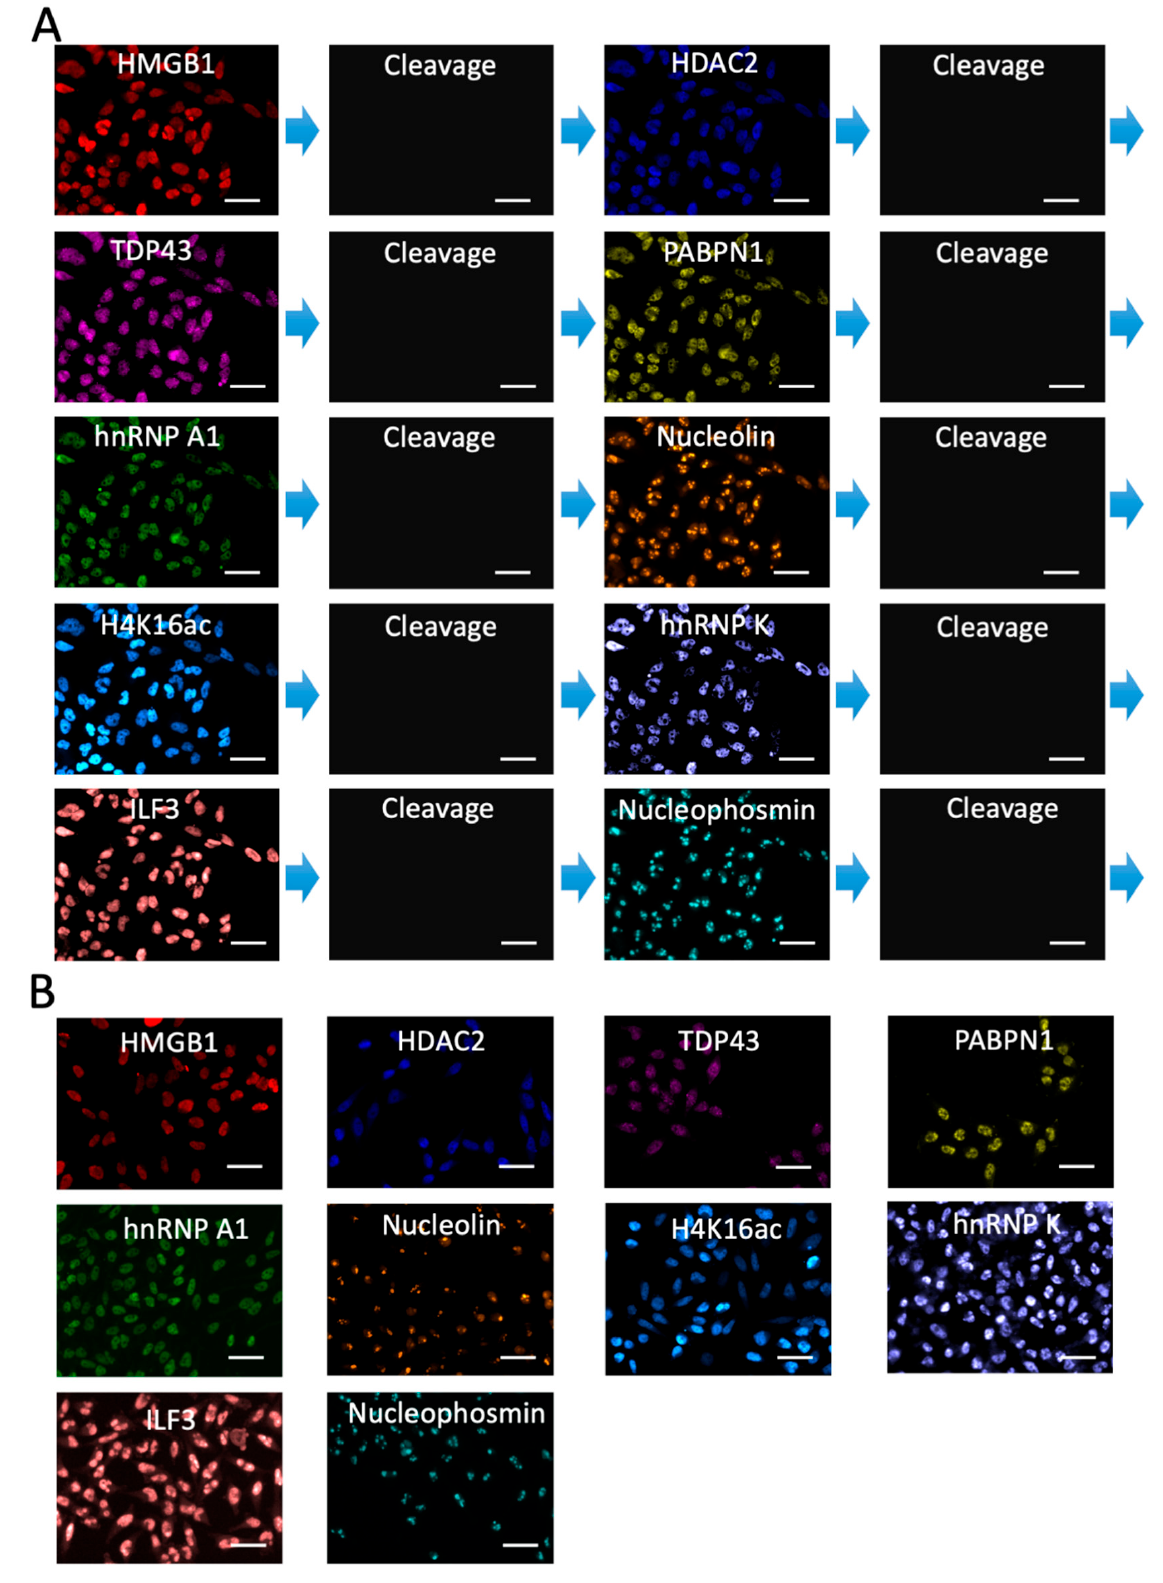
Figure 5. ( A ) Ten proteins were sequentially stained in the same set of HeLa cells with tyramide-N 3 -Cy5. ( B ) Ten proteins were individually stained in different HeLa cells with conventional TSA. Scale bars, 50 μ m.